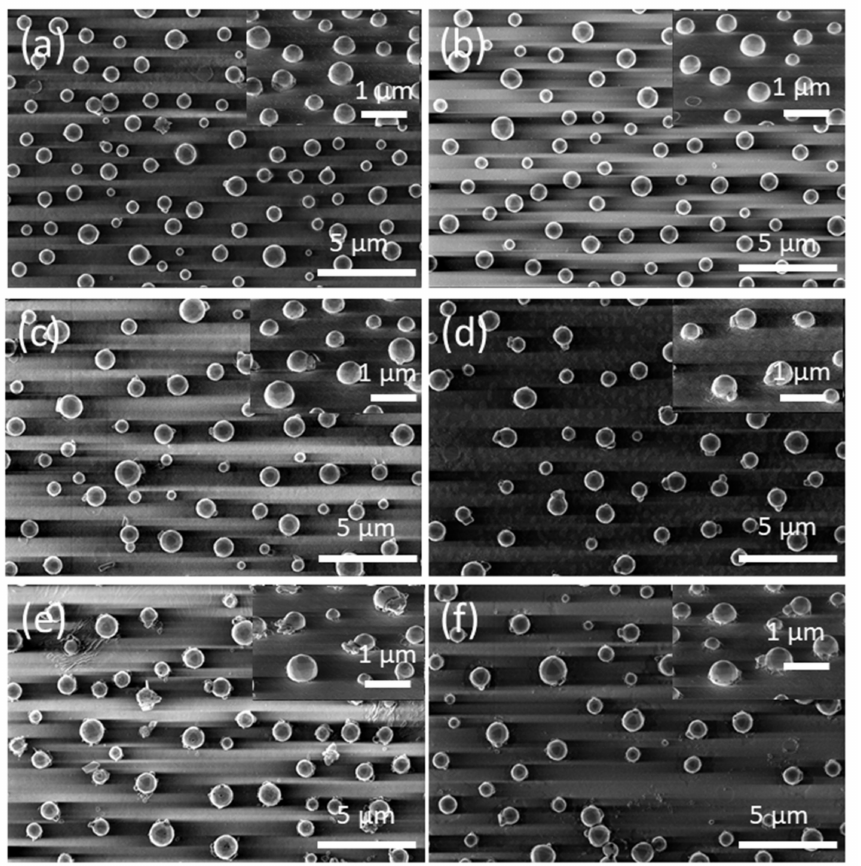
Figure 7. Top views of FE-SEM micrographs of vacuum-thermal-evaporated silver layers with a nominal thickness d Ag = 80 nm at different stages of the annealing step during the SSD process applying the constant temperature region program depicted in Figure 1 at T A = 500 ◦ C and ending at different t A values: ( a ) t A = 8 min, ( b ) t A = 17 min, ( c ) t A = 26 min, ( d ) t A = 34 min, ( e ) t A = 42 min, and ( f ) t A = 51 min. The insets depict the corresponding tilted FE-SEM micrograph views (with a tilt angle of 52 ◦ ). Temperature ramp rate =10 ◦ C /min. In all of these, cases a soda lime glass substrate has been